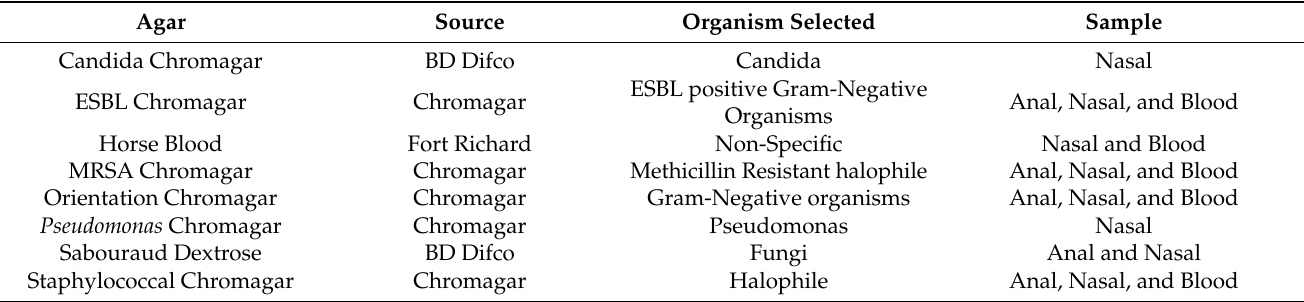
Table 1. Microbiological agar used for the study.